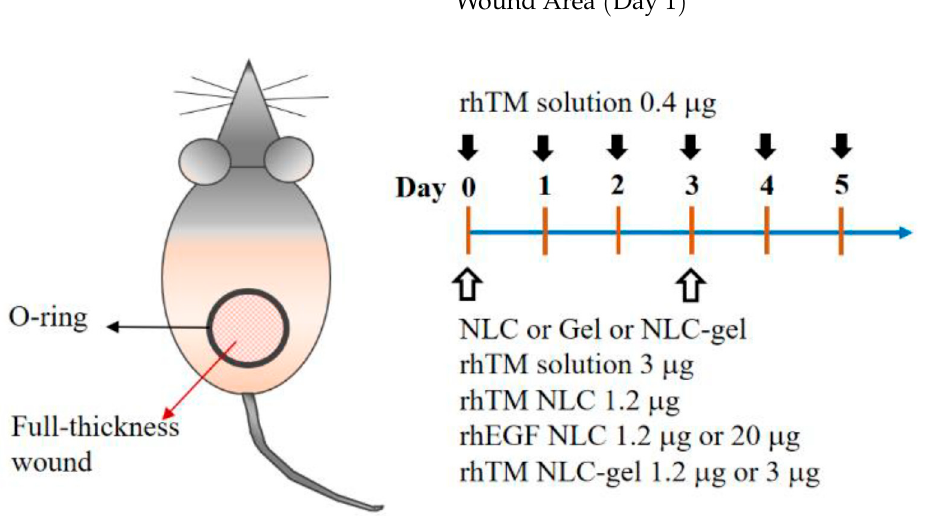
Figure 1. Topical treatment protocol. The black arrows denoted application days for rhTM solution 0.4 µg. The white arrows indicated application days for NLC, Gel, NLC-gel, rhTM solution 3 µg, rhTM NLC 1.2 µg, rhEGF NLC 1.2 µg, rhEGF NLC 20 µg, rhTM NLC-gel 1.2 µg and rhTM NLC-gel 3 µg, respectively. Each dose was applied in 50 µL solution or gel.